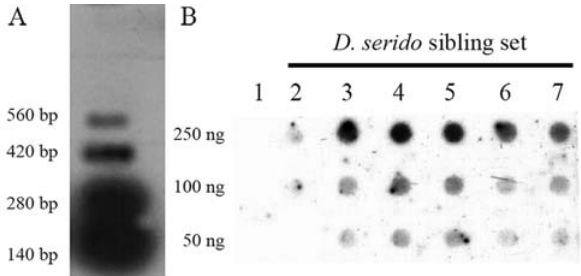
Figure 2 - A. Southern blotting membrane hybridization. The ladder pat- terncharacteristicofsequencesorganizedintandemobtainedbydigestion of genomic DNA (10 μ g) from Drosophila seriema with the Rsa I restric- tion enzyme and submitted to hybridization with D71C1B-139/10 probe. B. Dot-blot membrane hybridization using 50 ng, 100 ng and 250 ng of genomic DNA from each species applied to a nylon membrane and sub- mitted to hybridization with the D71C1B-139/10 probe. The following Drosophila species are shown: (1) D. buzzatii ; (2) D. koepferae ; (3) D. antonietae ; (4) D. gouveai ; (5) D. seriema ; (6) D. borborema ; and (7) D. serido